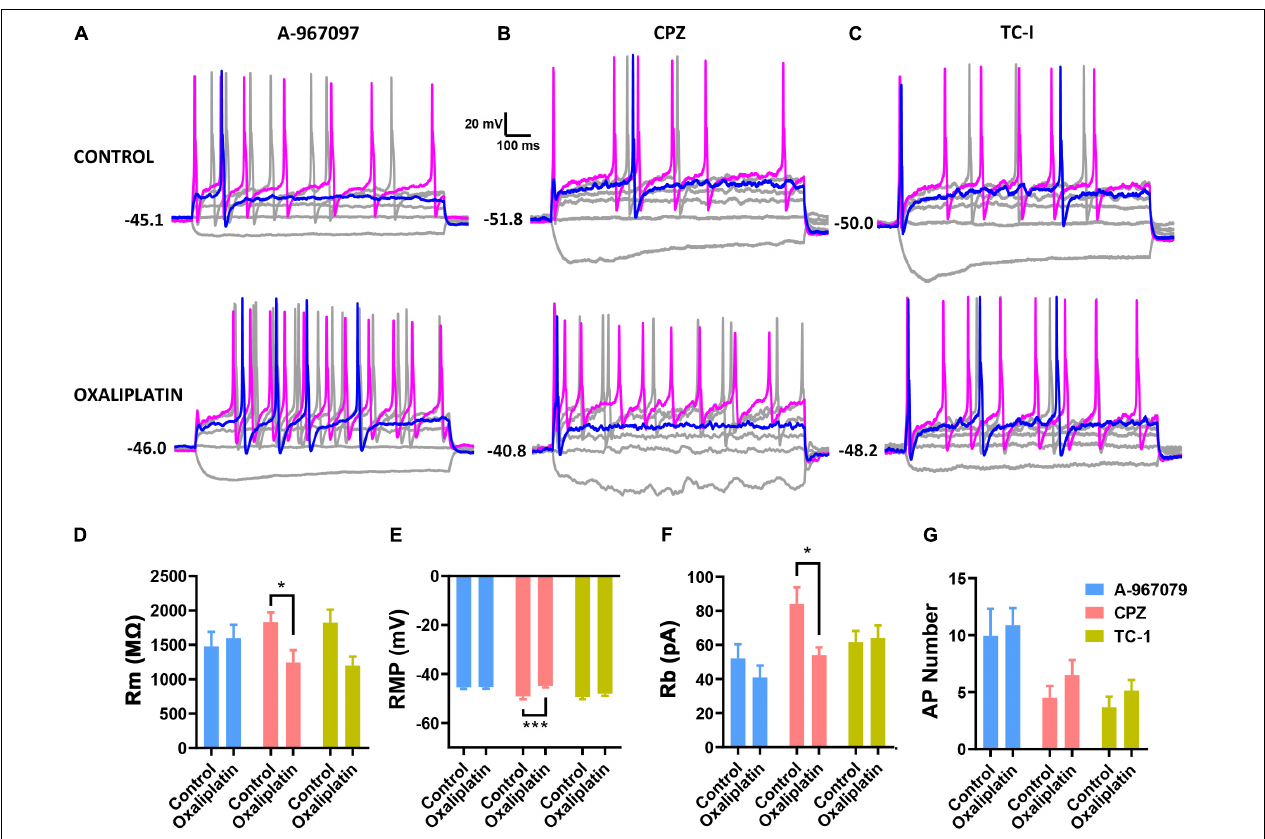
FIGURE 4 | Effects of selective TRP channel antagonists on the electrophysiological properties of IB4 + and IB4 − subpopulations of small DRG neurons. Selective antagonists for TRPA1 (1 µ M A-967097), TRPV1 (10 µ M Capsazepine, CPZ), or TRPM8 (10 nM TC-I) were pre-treated in the recording chamber for 15 min before the addition of 50 µ M oxaliplatin. The passive and active properties of IB4 + and IB4 − subpopulations of small DRG neurons were recorded and presented in the same way described in the legend of Figure 1 . (A-C) Representative recordings in the absence or presence of oxaliplatin, and in the presence of A-967097, Capsazepine, and TC-I, respectively. Effect of oxaliplatin on Rm (D) , RMP (E) and Rb (F) in each group of TRP antagonists. (G) Number of action potentials evoked by 100 pA current injection in each group of cells. n = 6–12 for each group (see detailed numbers for each group in results). * P < 0.05, *** P < 0.001, Student’s t